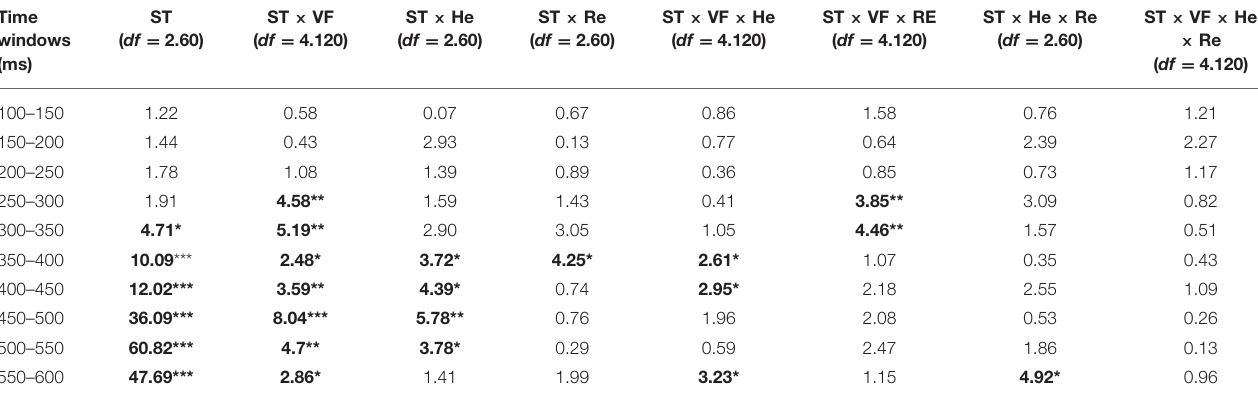
TABLE 2 | F -values of the ANOVA for the ERP waveforms involved in the stimulus-type condition. Time windows